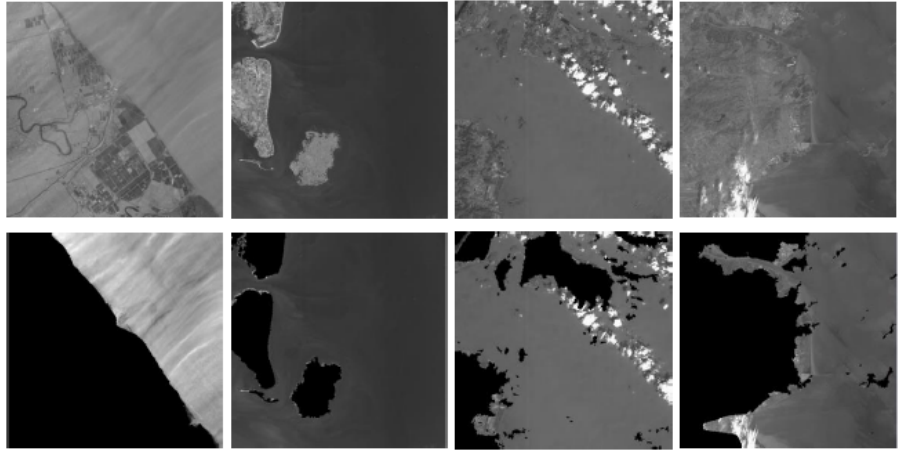
Figure 2. The original images are in the first row of the figure, and the results of sea and land segmentation are the second row. Among them, the black area represent the land